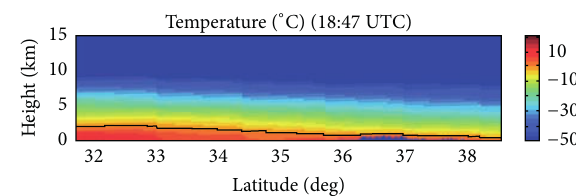
Figure 4: The temperature profile determined from CloudSat CPR. The dark line shows the freezing level.